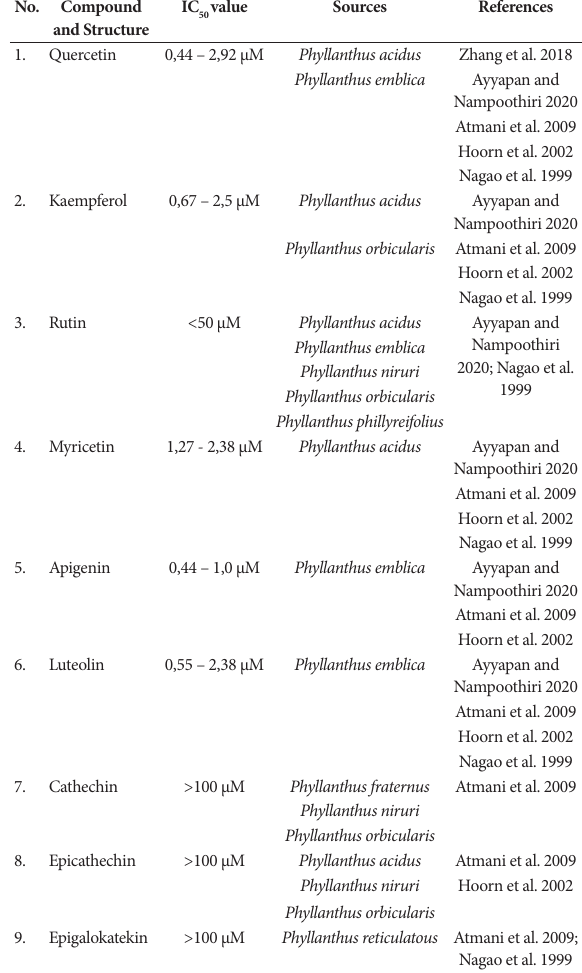
Table 2. Inhibitory activity of xanthine oxidase from flavonoids of the Phyllanthus